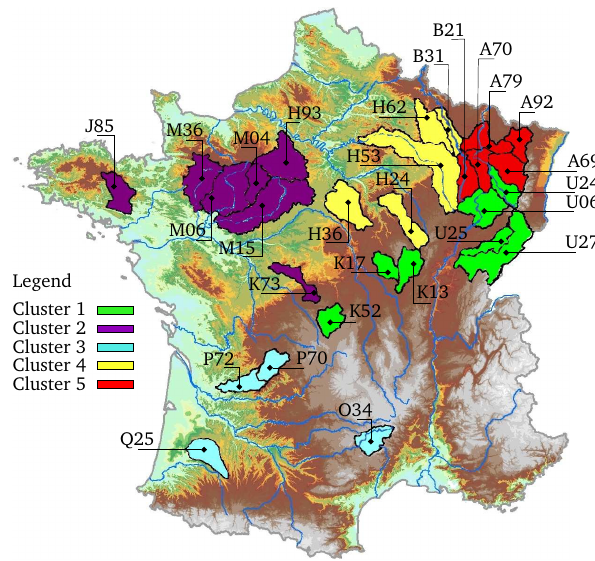
Fig. 1. Location of the catchments grouped by clusters. Some of them have been used in the BGS-CV process, while the others have been used for extrapolation. The colours identify the five regions evaluated in this